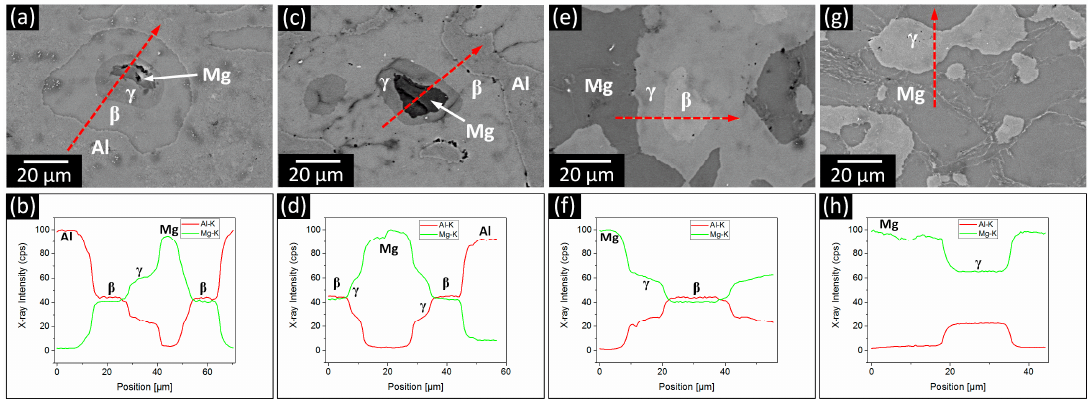
Figure 4. The SEM images and EDX elemental concentration profiles for the composites hot-pressed at 673 K with an initial magnesium content of ( a , b ) 10, ( c , d ) 40, ( e , f ) 80 and ( g , h ) 90 vol %. The dashed red arrows represent the scanned EDX line.